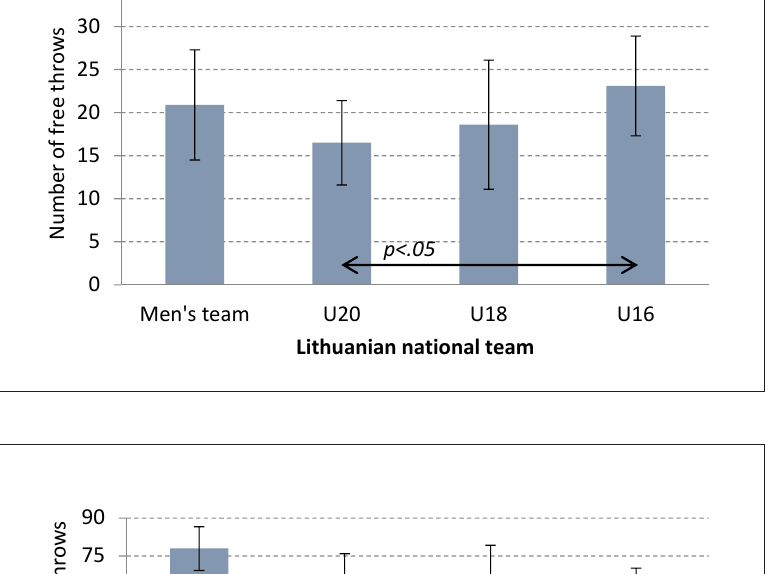
Figure 4. The accuracy of 3-point shots for men’s basketball teams in the European championship matches (average per one game)